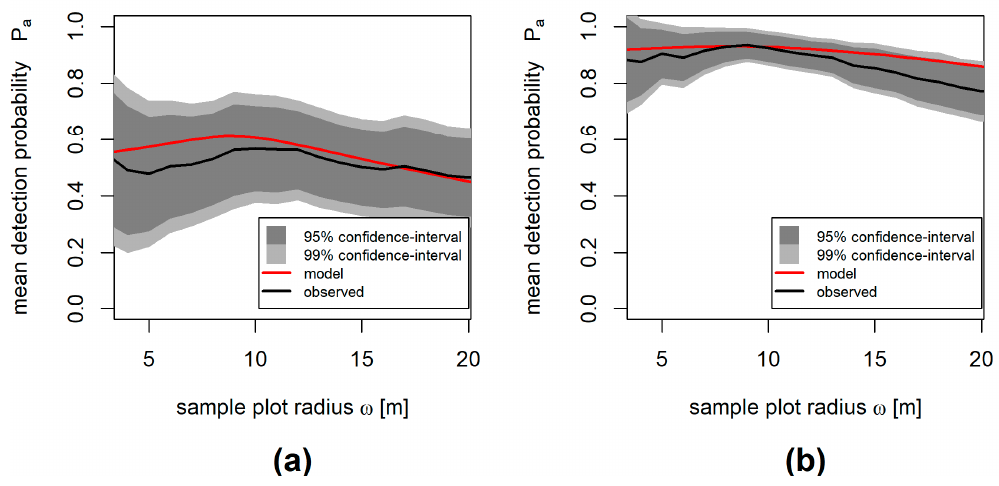
Figure 7. Mean detection probability P a for di ff erent sample plot radii ω using TLS in multi-scan mode for both strata (small trees, left and large trees, right). The black line represents the observed data; the red line represents the model prediction. The light and dark grey areas are the 99% and 95% confidence intervals computed from the observed data, respectively. ( a ) Small trees (5 cm ≤ dbh < 20 cm) and ( b ) large trees (dbh ≥ 20 cm).